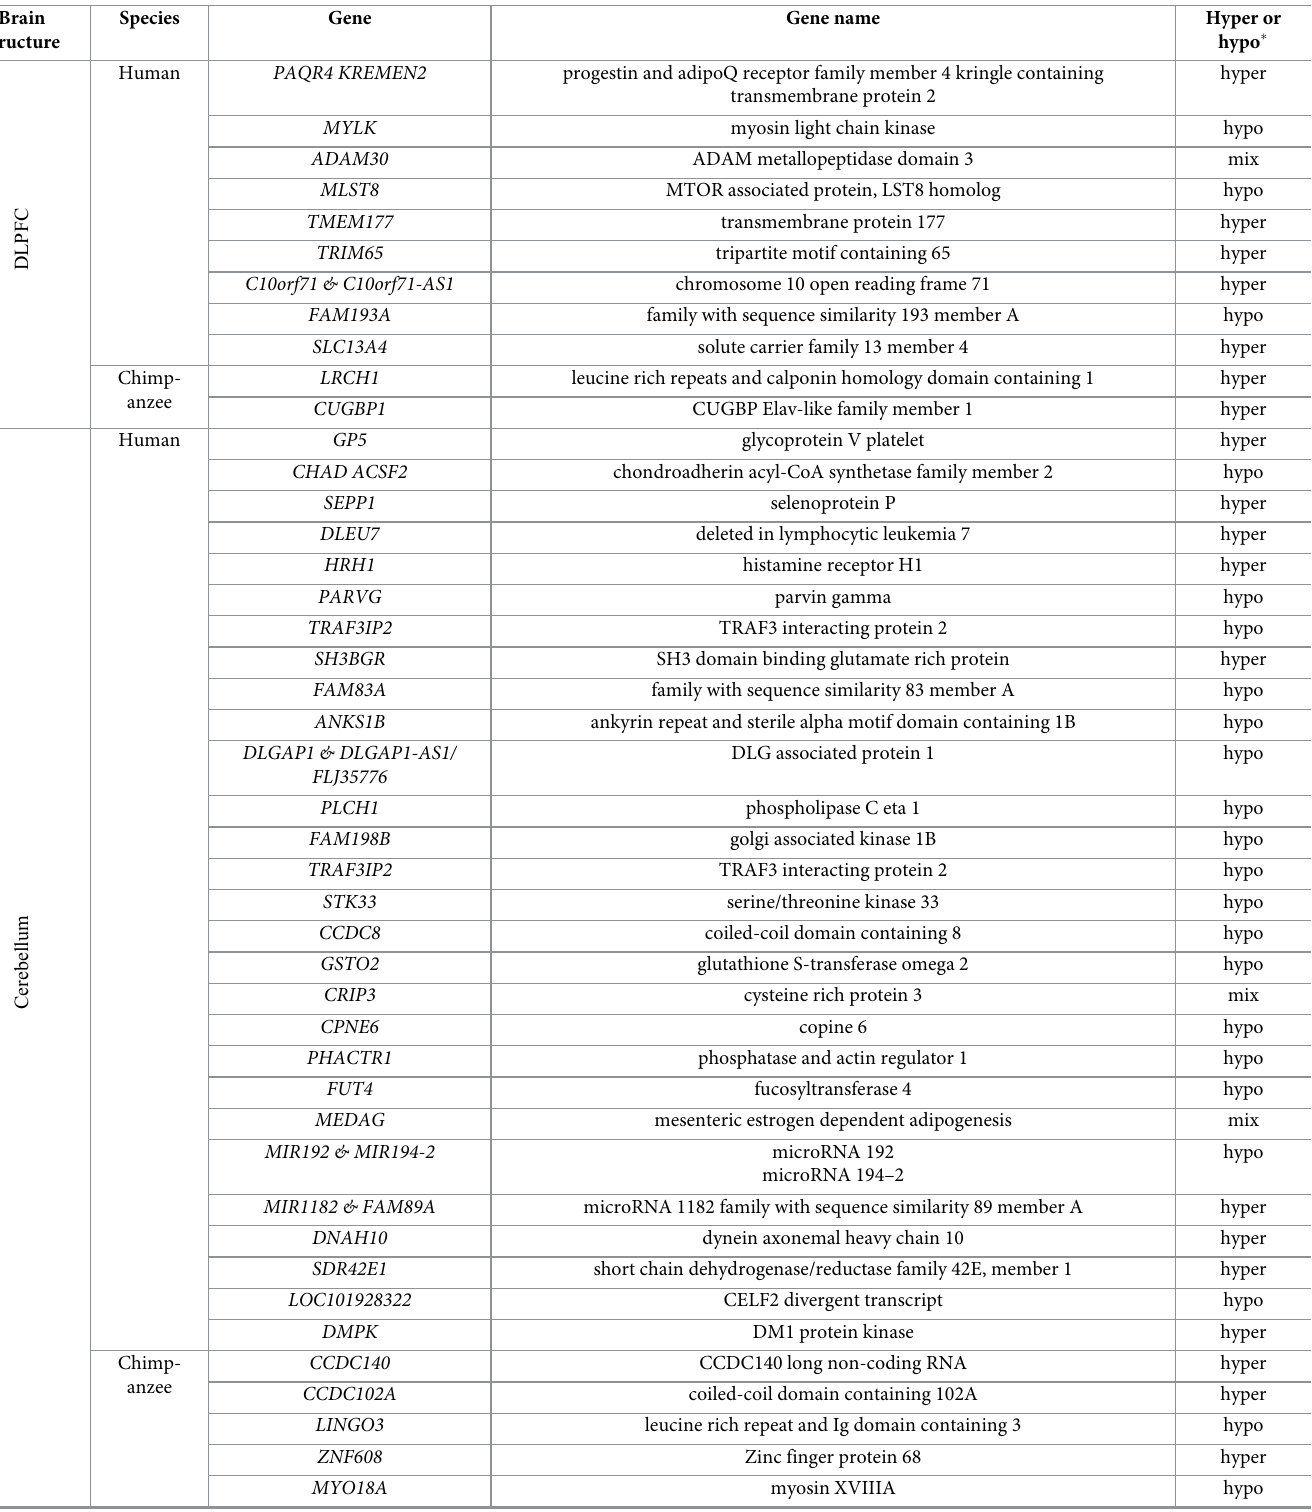
Table 1. Human and chimpanzee brain region-specific